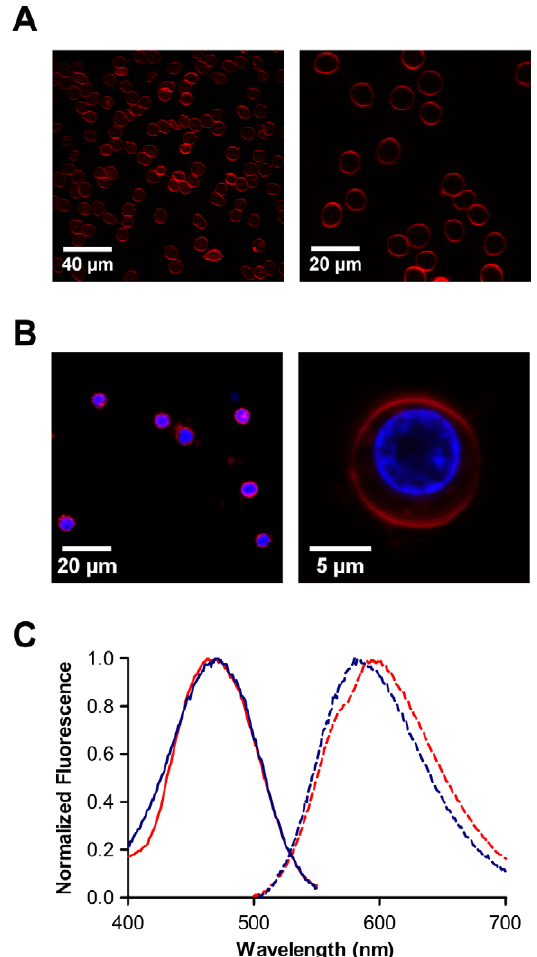
Figure 1. Visualization and spectral characterization of di-8- ANEPPS labeled cells. Labeled erythrocytes (A) and PBMC (B) were observed under a confocal fluorescence microscope to confirm that only the plasma membrane was stained (shown in red). Additional staining of the nucleus with Hoechst dye (blue) was performed for PBMC, only for microscopy observation. Excitation and emission spectra (C) were taken for each labeled cell type, differing on peaks due to different membrane environments (blue trace for PBMC and red trace for erythrocytes; filled line for excitation and dashed line for emission spectra). Excitation at 465 nm for both cell types; emission at 600 nm and 585 nm for erythrocytes and PBMC, respectively.